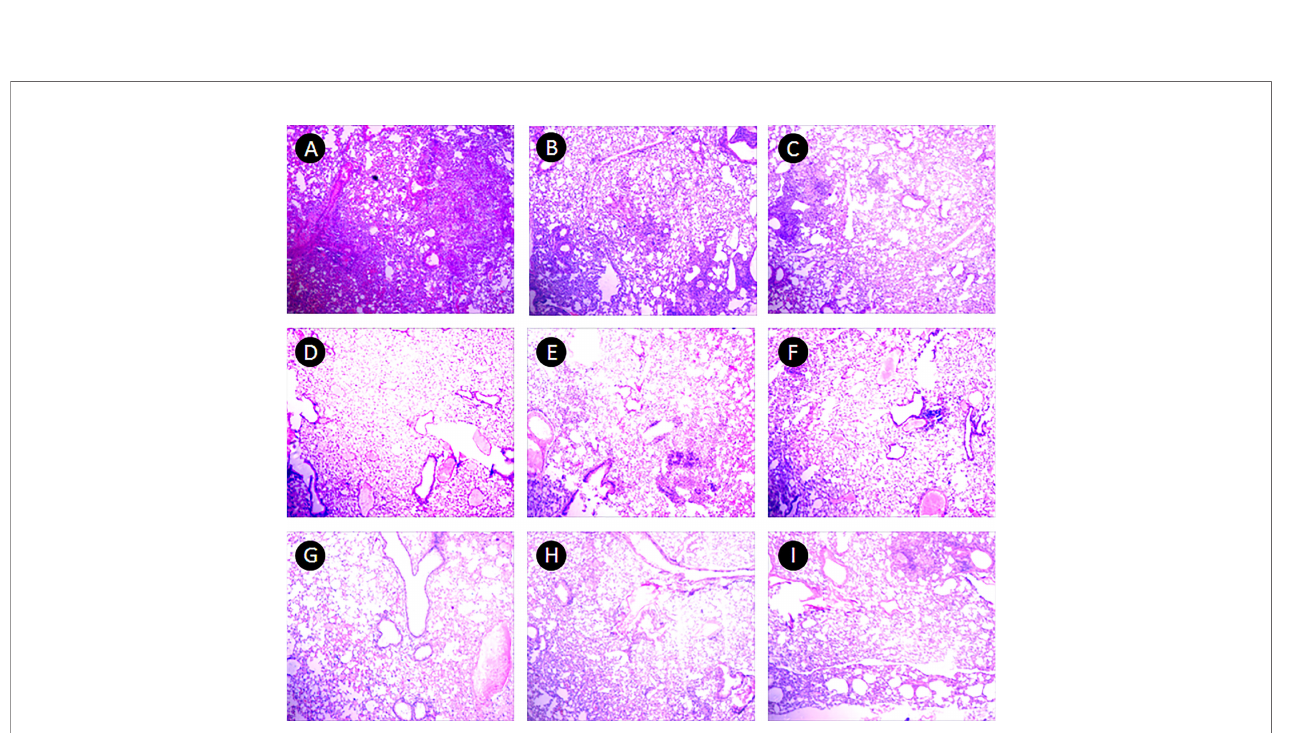
FIGURE 5 | Pulmonary histopathological changes. This fi gure shows representative photomicrographs (H and E, 40×) of lung tissue obtained from mice each group at 17-18 days after the third immunization. (A) PBS group. (B – E) , 10 m g, 50 m g, 100 m g and 200 m g ag85a/b DNA IM groups. (F – I) , 10 m g, 50 m g, 100 m g and 200 m g ag85a/b DNA EP groups. IM, intramuscular injection; EP,